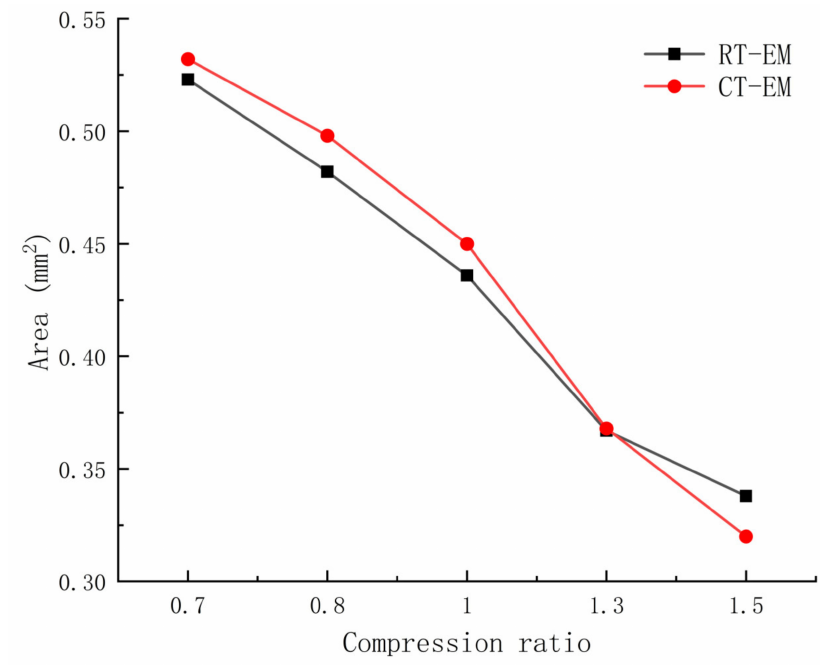
Figure 9. Cross-sectional area of the micro-grooved